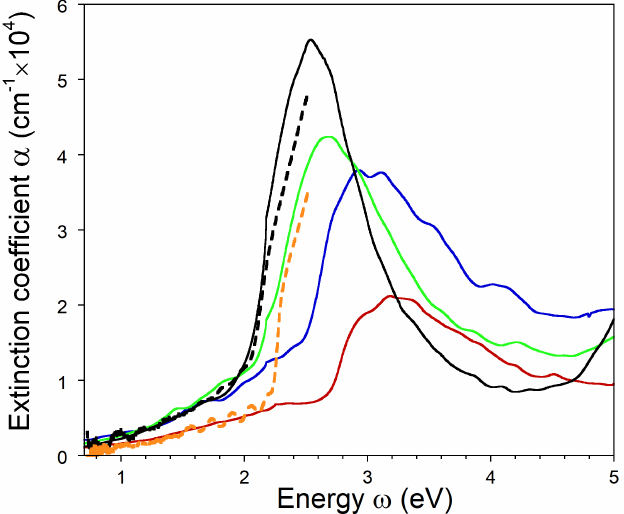
Figure 7. Calculated extinction coefficients for As 1 − z Sb z –Al x Ga 1 − x As 1 − y Sb y and As–Al x Ga 1 − x As metamaterials consisting of Sb, As 0.33 Sb 0.67 , As 0.67 Sb 0.33 , and As NPs embedded in the semiconductor matrices (solid black, green, blue, and red lines, respectively). The experimentally measured extinc- tion coefficients in As 1 − z Sb z –Al x Ga 1 − x As 1 − y Sb y and As–Al x Ga 1 − x As metamaterials are shown by dashed black and orange lines,